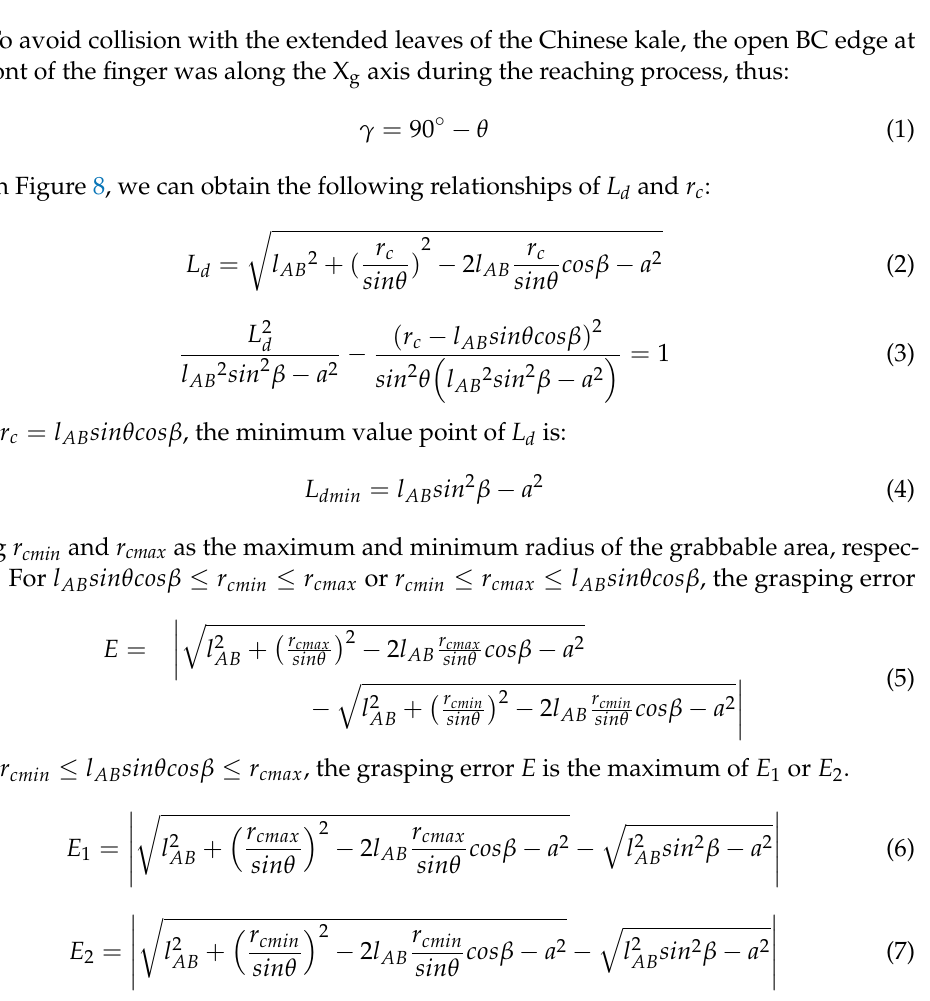
Figure 8. Parameters of the double-pivot rotation finger.